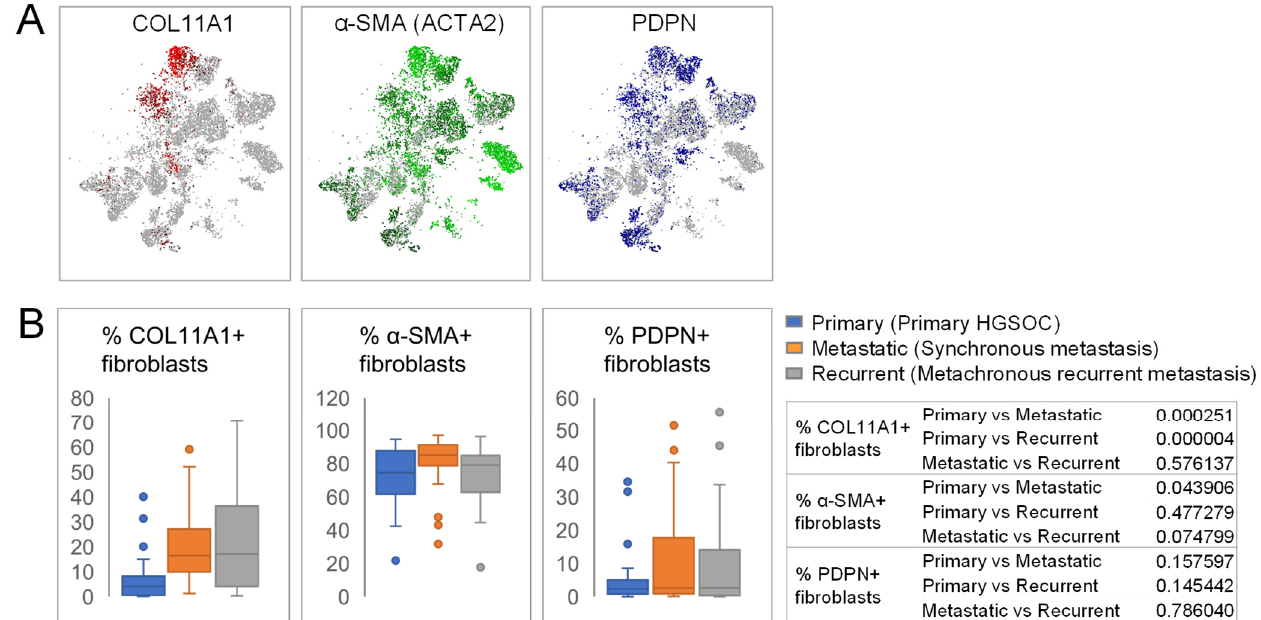
Figure 3. Distribution of three CAF subsets during HGSOC progression. ( A ) t-SNE plots of COL11A1, ACTA2 (encoding for α -SMA), and PDPN mRNA expression in ovarian CAFs. The images were generated using SCope software and public single-cell RNA sequencing data deposited into the ArrayExpress database at EMBL-EBI under accession numbers E-MTAB-8107. ( B ) Box and whisker plots show percentages of COL11A1 + , α -SMA + , and PDPN + CAFs in primary tumors, synchronous metastases, and metachronous recurrent metastases. The Y -axis represents the percentage of the CAF subtype among all morphologically defined CAFs. The table shows p values for comparisons between every two groups of samples within the three